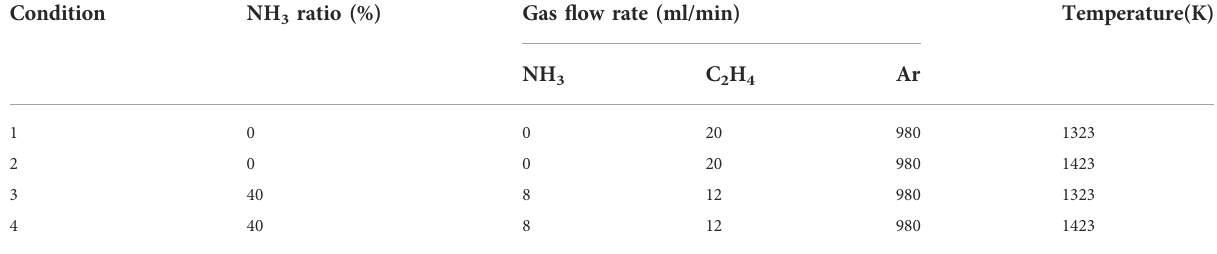
TABLE 1 Pyrolysis conditions. Condition